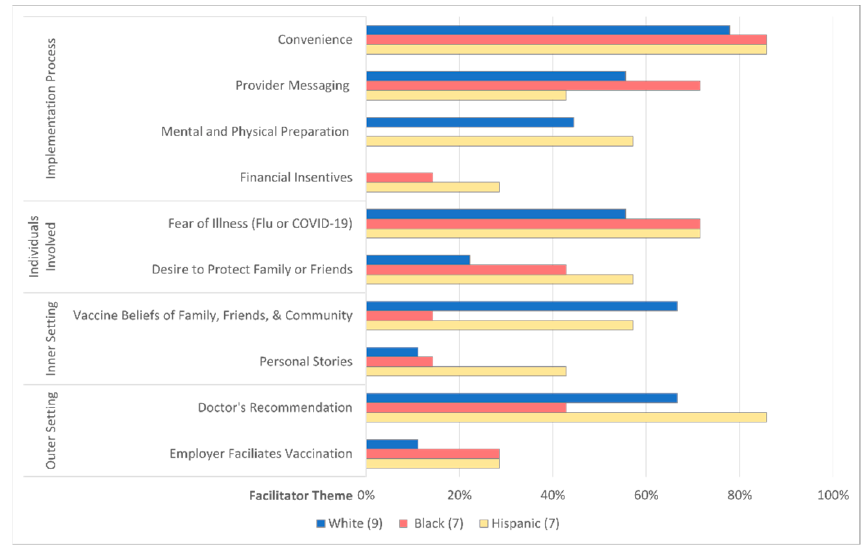
Figure 4. Vaccine Facilitator Themes Differ by Race and Ethnicity. Vaccine facilitator themes are organized by Consolidated Framework for Implementation Research (CFIR) domains. The bar graph compares the frequency each facilitator theme occurred in White, Black, and/or Hispanic par- ticipants.